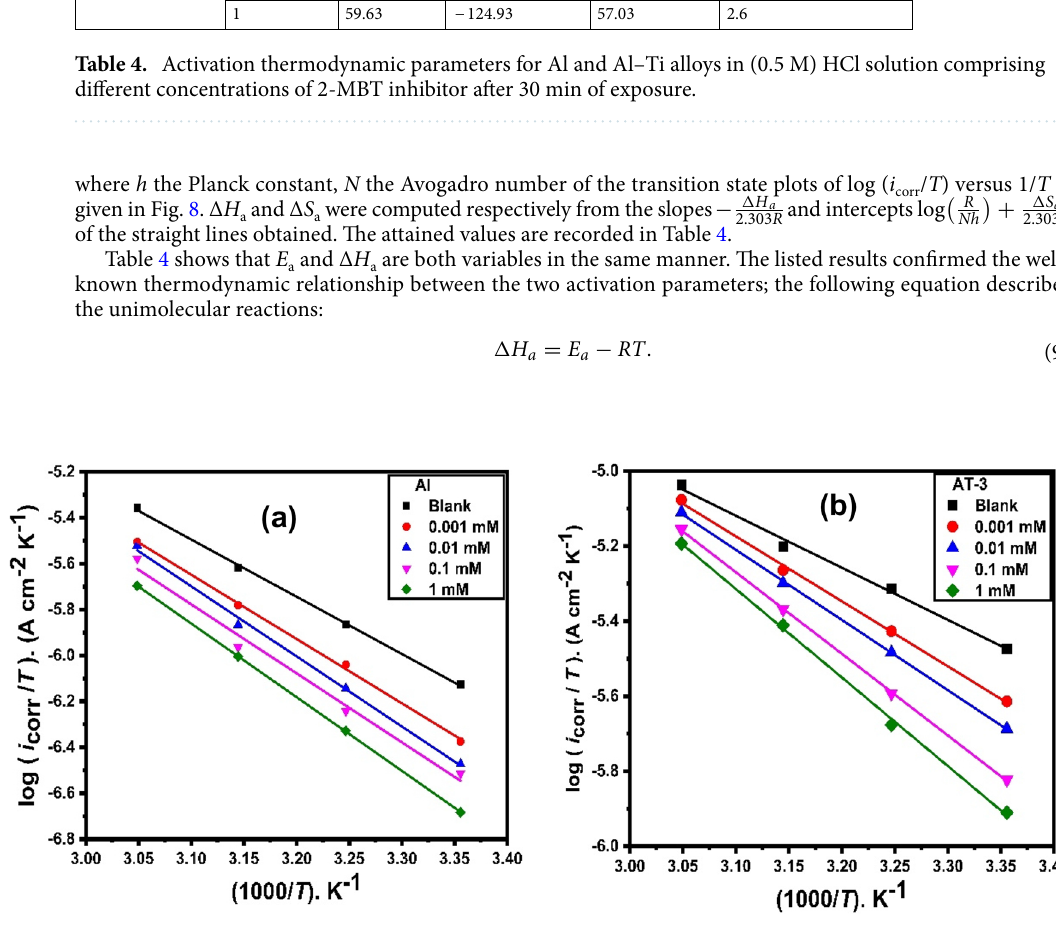
Figure 8. Transition state plots for ( a ) pure Al and ( b ) AT-3 alloy in HCl (0.5 M) comprising different concentrations of 2-MBT at different temperatures after 30 min